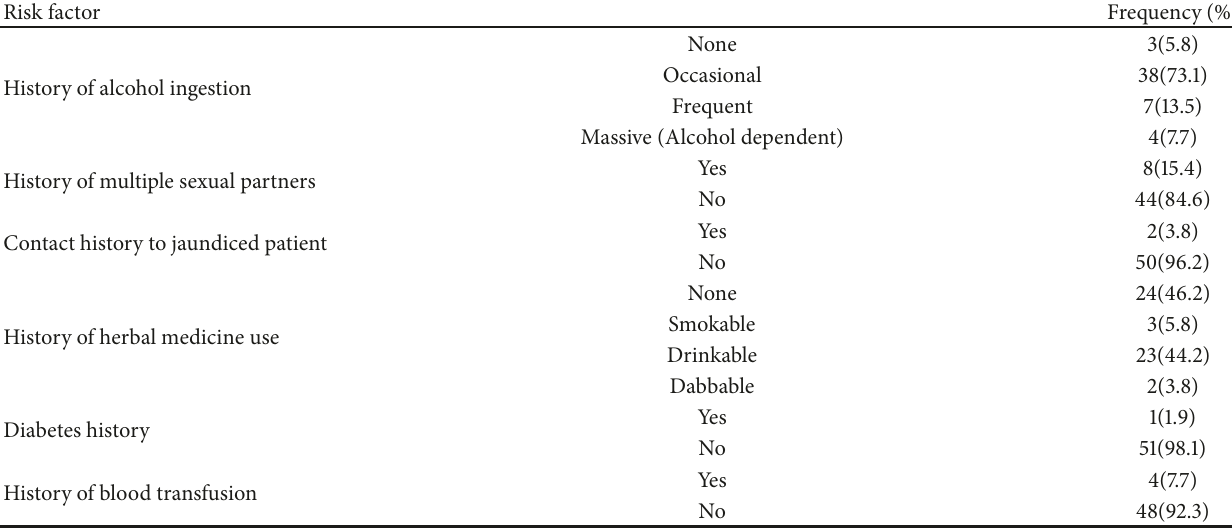
Table 2: Risk factors for ascites among study